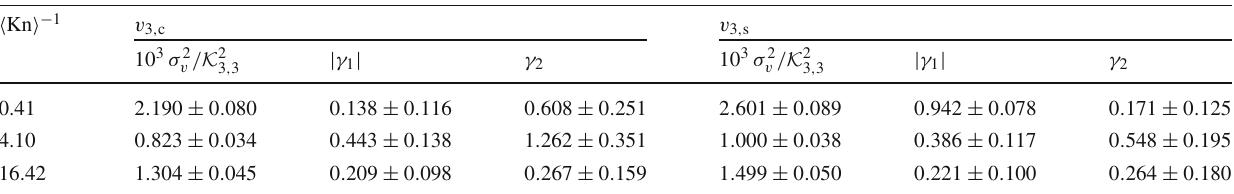
Table 12 Moments of the conditional probability distributions p v | ε (v 3 , c / s | ε 3 , c / s ) of the final-state flow harmonics computed for 10 4 events at b = 9 fm. The variance σ 2 v is divided by the square K 2